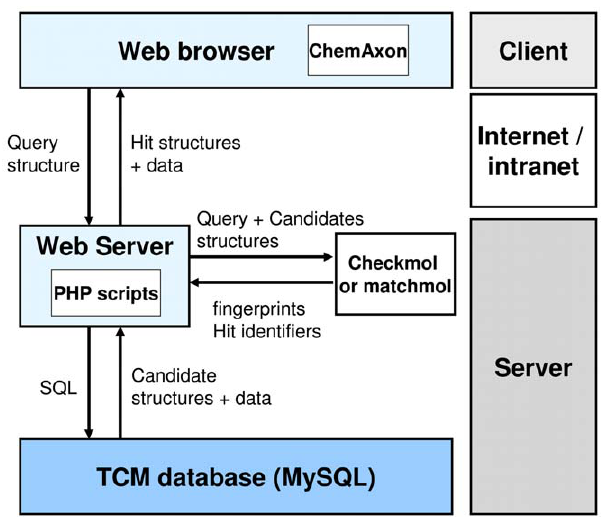
Figure 4. For search-by-specifying-molecular-properties, a search script written in PHP is used to search and retrieve TCM compounds that satisfied all the input properties. Two programs, checkmol and matchmol, are used to perform the background structure searching and matching process. The queried structure is read by the checkmol program to generate molecular descriptors, which is then used in the preliminary search in the TCM database. The matchmol program is responsible for full structure compar- ison of the input structures from checkmol. For additional